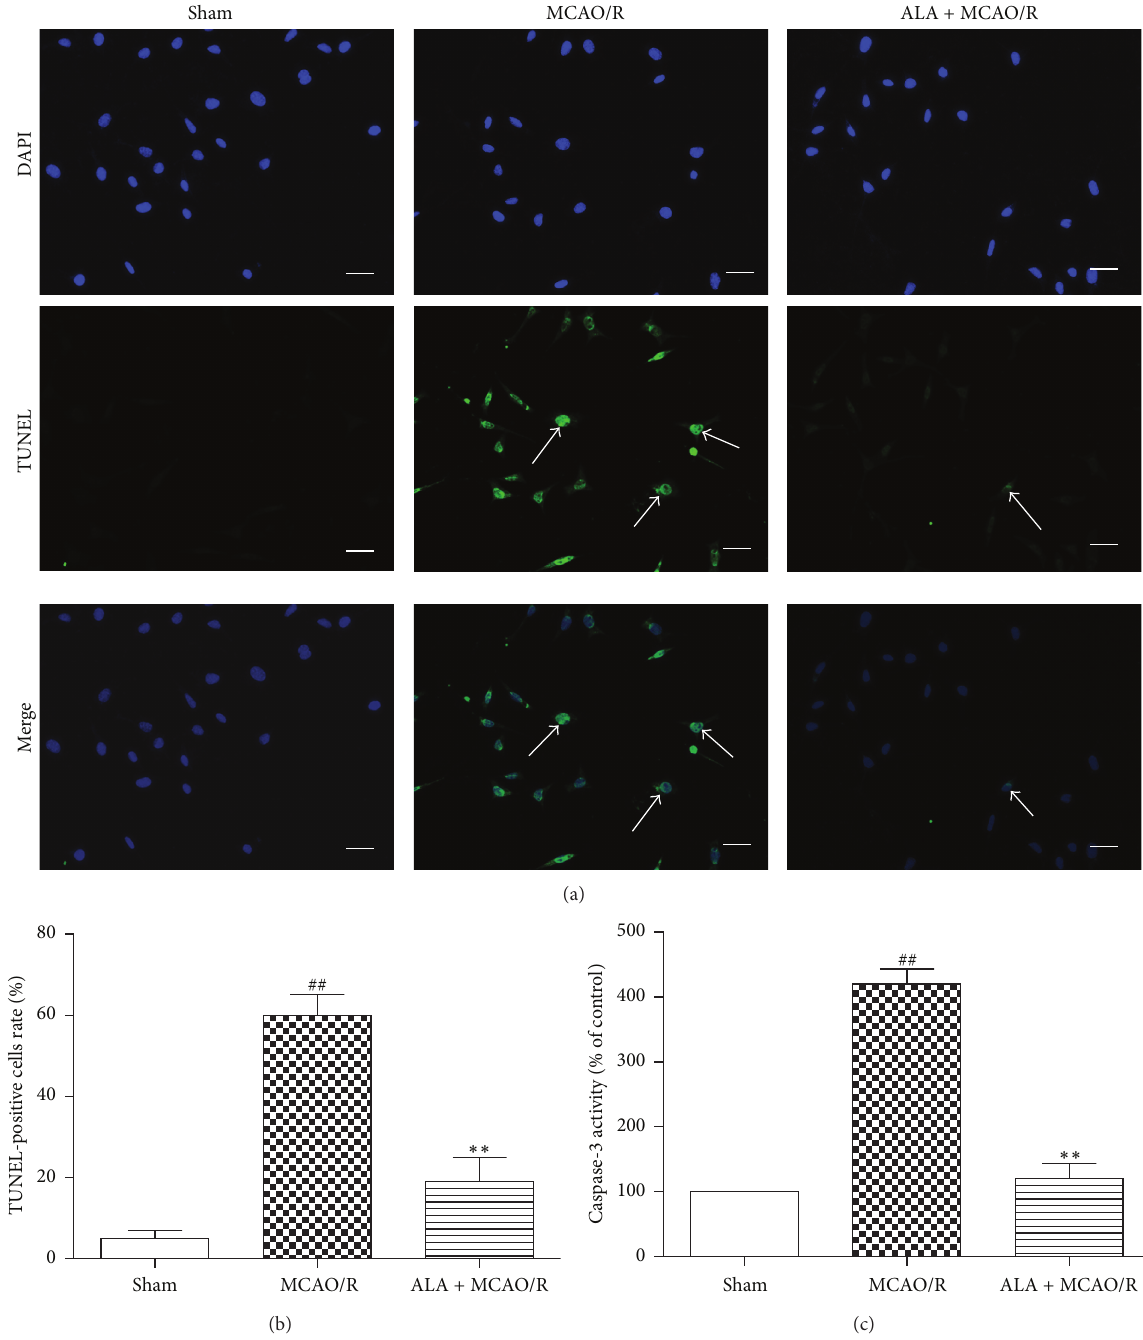
Figure2:ALAattenuatedMCAO/R-inducedneuronalapoptosis.(a)DNAfragmentationinapoptoticneuronalcellswasdetectedbyTUNEL; arrows represent TUNEL-positive cells; bar = 50 𝜇 m. (c) Quantitative analysis of TUNEL-positive cells rate. For the ALA + MCAO/R group, ALA (40 mg/kg, i.p.) was daily administered to rats for 3 days. For the sham and MCAO/R groups, the rats were given the same amount of ethanol. Data were expressed as means ± SEM. ## 𝑃 < 0.01 compared with the sham group. ∗∗ 𝑃 < 0.01 compared with the MCAO/R